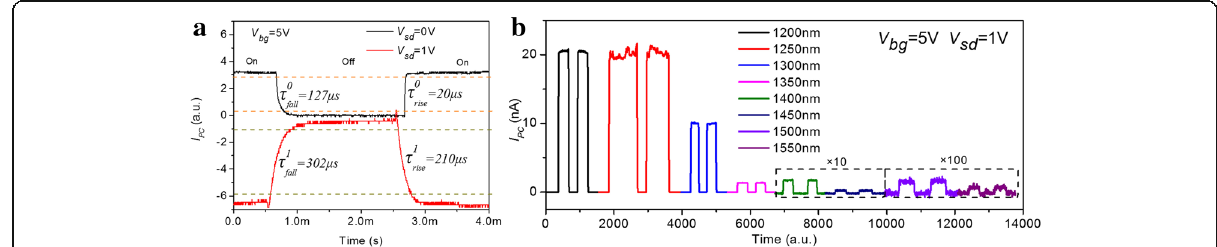
Fig. 5 Photoresponse time and spectral range of multi-layered MoTe 2 phototransistor. a Time-resolved photocurrent at V bg = 5 V and V sd = 0 V (black line) and 1 V (red line), respectively. b Photoresponse at different photoexcitation